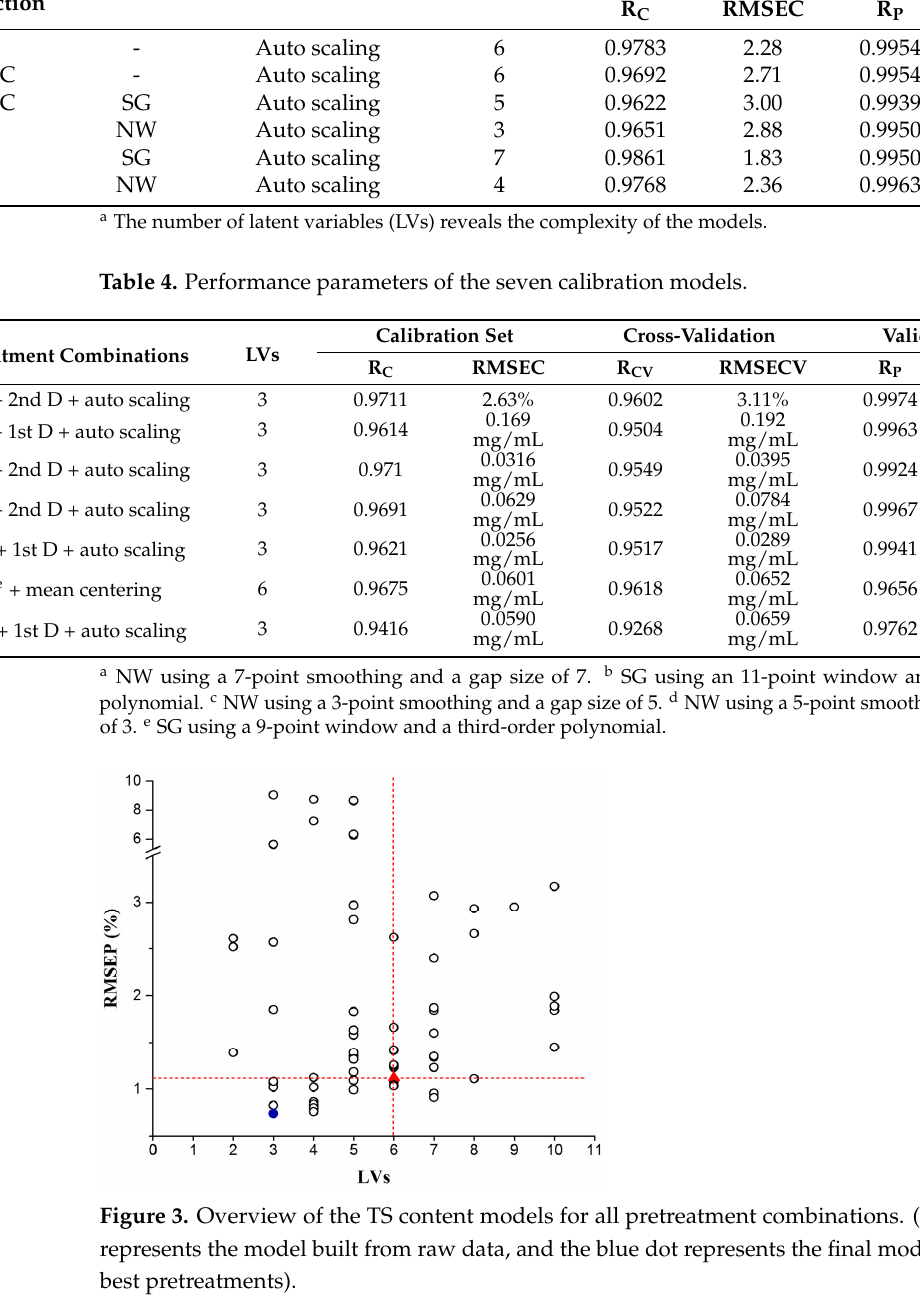
Figure 2. The NIR spectra during the process under normal operating conditions.